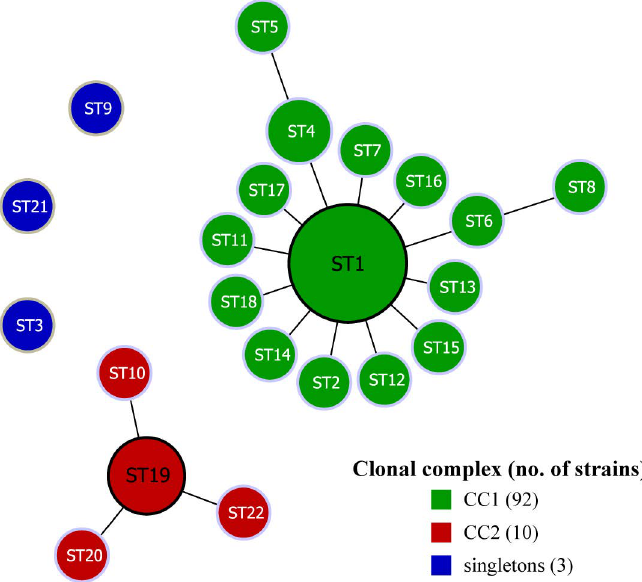
Figure 4. The goeBURST analysis of 105 PaWB phytoplasma strains. Defined at SLV level to the clonal complexes (groups). Each ST is represented by a circle; the size of the circle is proportional to the number of